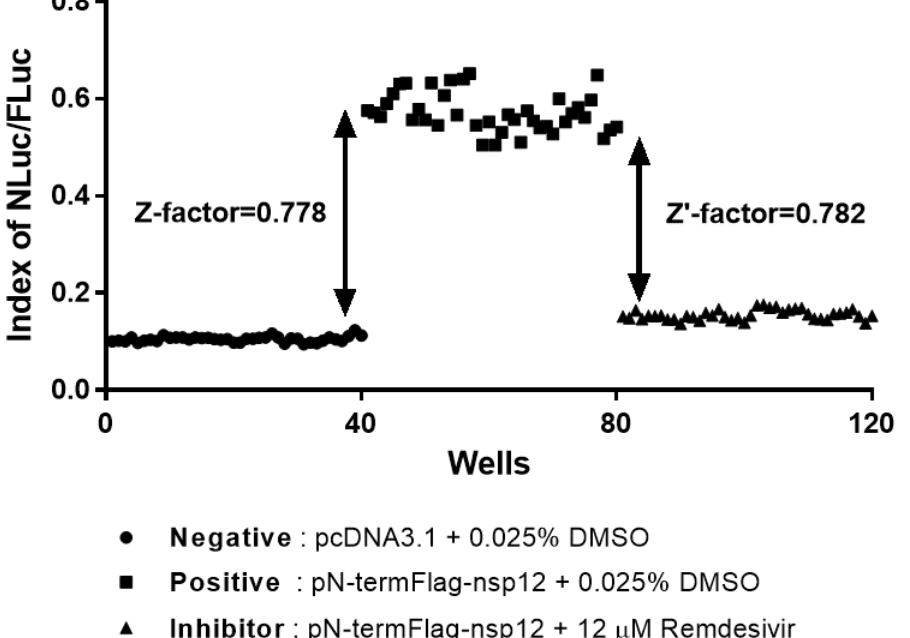
Figure 6. Validation of the accuracy of the cell-based reporter assay for Middle East respiratory syndrome coronavirus (MERS-CoV) RNA-dependent RNA polymerase (RdRp) as a high-throughput screening system. In the assay, 96-well plate-seeded HEK293T cells were transfected with p(+)FLuc- (−)UTR -NLuc and pcDNA3.1 followed by treatment with 0.025% DMSO (negative group, n = 40 wells), transfected with pN-termFlag-nsp12 followed by treatment with 0.025% DMSO (positive group, n = 40 wells), or transfected with pN-termFlag-nsp12 followed by treatment with 12 μM remdesivir (inhibitor group, n = 40 wells). Then, FLuc and NLuc activities were measured. According to Zhang’s formula, the Z-factor value between the positive and negative groups was 0.778, indicating that this assay system is excellent for detecting MERS- CoV RdRp activity. The Z′ -factor between the positive and inhibitor groups was 0.782, indicating that remdesivir can be used as a positive control for MERS-CoV RdRp-specific inhibitors.